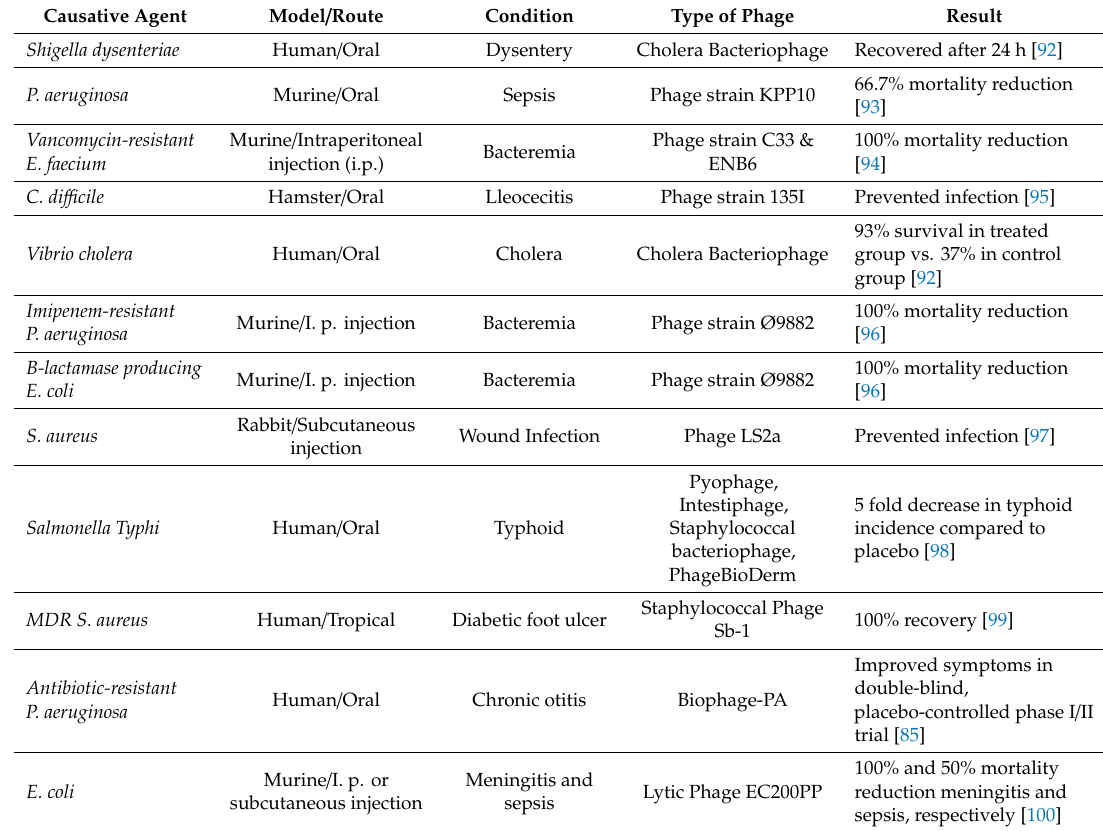
Table 4. Phage therapy in humans and in animal